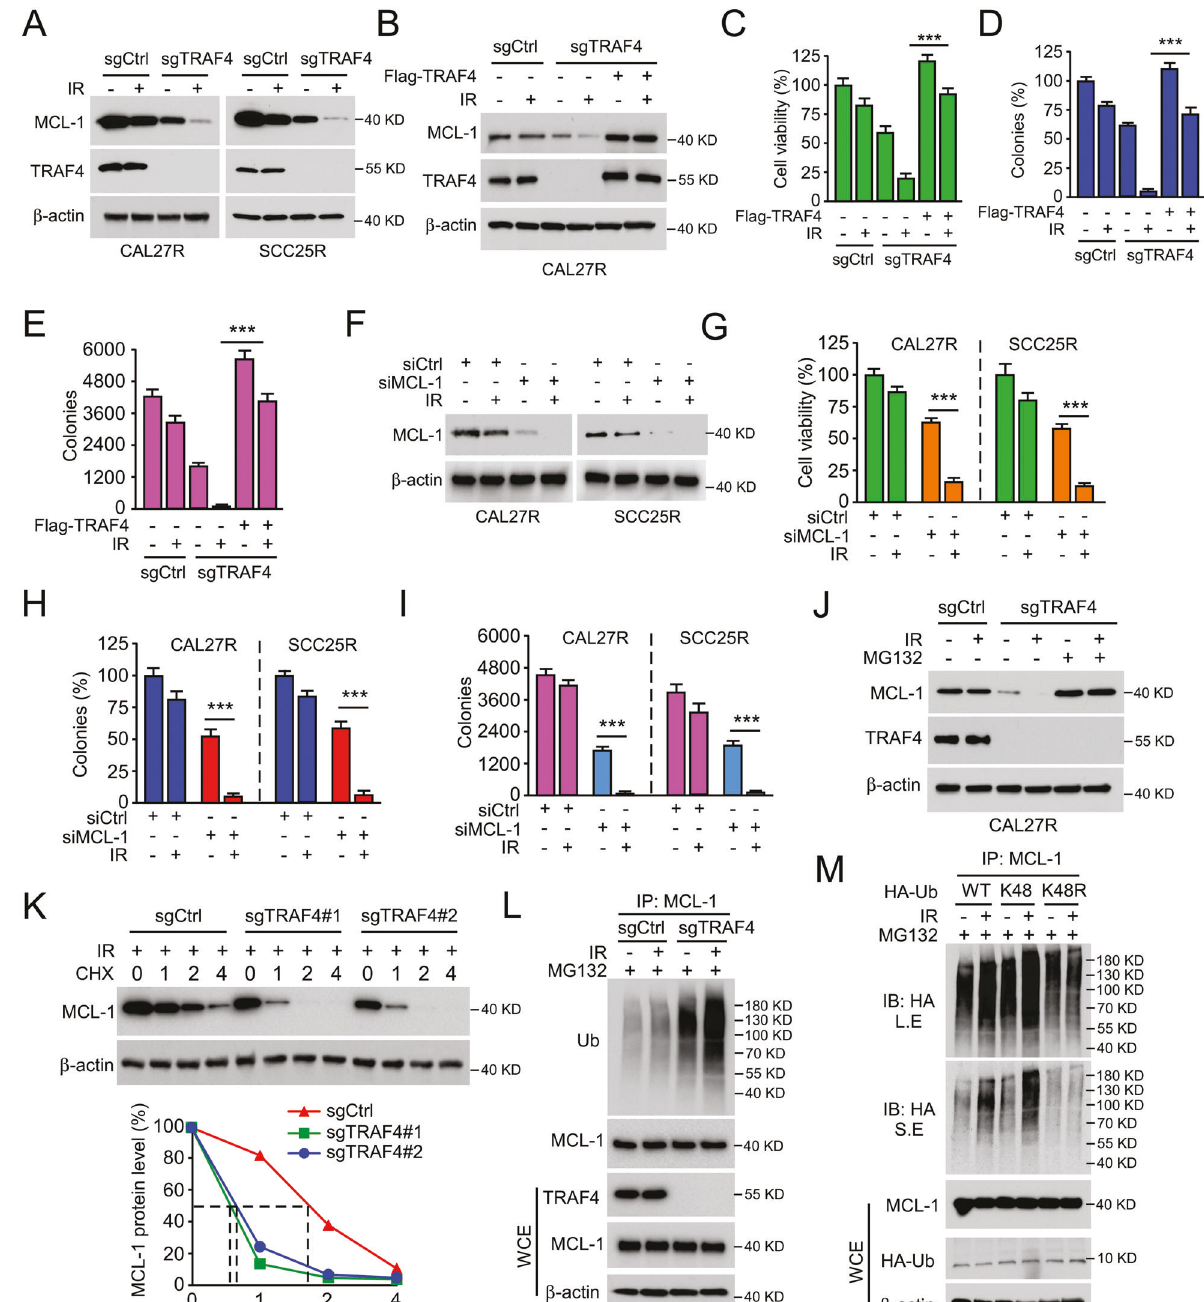
Fig. 3 Depletion of TRAF4 reduces IR-induced downregulation of MCL-1. A Immunoblotting for MCL-1 expression in TRAF4 knockout CAL27R and SCC25R cells treated with/without IR (2 Gy) for 72 h. B TRAF4 was transiently transfected into TRAF4 knockout CAL27R cells for 24 h, then treated with IR (2 Gy) and cultured for 72 h. Immunoblotting was used to detect MCL-1 and TRAF4 expression. C – E Ectopic expression TRAF4 compromised IR-induced tumor cell growth inhibition. TRAF4 knockout CAL27R cells were transfected with Flag-TRAF4 for 24 h, then treated with IR (2 Gy) and cultured for 72 h. MTS assay was used to determine the cell viability ( C ), plate colony formation assay to analyze the colony formation ( D ) and soft agar assay to assess the anchorage-independent cell growth ( E ). F CAL27R and SCC25R were transfected with siMCL1 for 24 h, followed by IR (2 Gy) treated and cultured for 72 h. Immunoblotting was performed to detect MCL-1 expression. G – I Silencing of MCL-1 inhibited the growth of tumor cells. CAL27R and SCC25R cells were transfected with siMCL1 for 24 h, followed by IR (2 Gy) treated and cultured for 72 h. MTS assay was performed to determine the cell viability ( G ), plate colony formation assay to analyze the colony formation ( H ) and soft agar assay to assess the anchorage-independent cell growth ( I ). J Immunoblotting for MCL-1 expression in CAL27R cells treated with IR (2 Gy) for 72 h, followed by incubation with MG132 (25 µM) for 6 h. K Immunoblotting for MCL-1 expression in CAL27R cells treated with IR (2 Gy) and incubated with CHX for different time points. L TRAF4 knockout CAL27R cells were treated with MG132 (25 μ M) for 6 h, then with IR (2 Gy) for 1 h. Cell extracts were subjected to immunoprecipitation (IP) assay to analyze MCL-1 ubiquitination level. M 293T cells were transfected with HA-Ub, HA-Ub-K48, and HA-Ub-K48R for 48 h, followed by IR (2 Gy) treated for 20 min. IP assay was performed to detect MCL-1 ubiquitination level. L.E long exposure, S.E short exposure. All data are means ± s.e.m. *** p < 0.001, a signi fi cant difference between groups as indicated. Cell Death and Disease